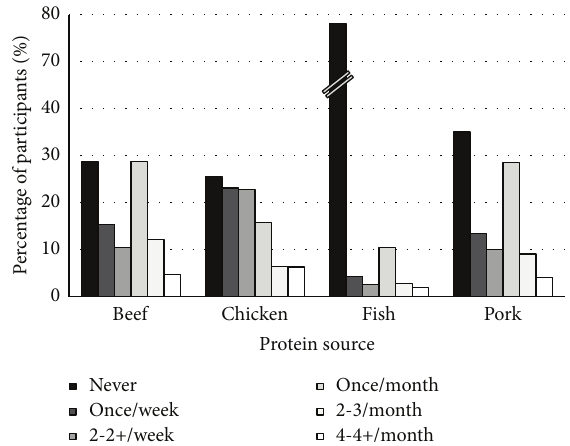
Figure 1: Consumption rate and frequency of protein sources by pregnant women.